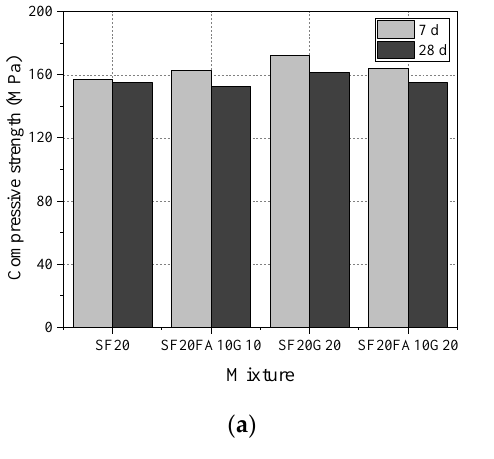
( b ) Figure 1. Compressive and flexural strengths of EUHPC under standard curing: ( a ) compressive strength; ( b ) flexural strength. 3.2.2. Mechanical Properties under Steam Curing The compressive and flexural strengths of EUHPC under steam curing are summa- rized in Table 4 and Figure 2. The compressive strength of specimens under steam curing fell within the range of 151.8 – 161.5 MPa at the age of 28 days and within the range of 155.1 – 172.5 MPa at the age of 7 days. There was no significant increase in 28 days com- pressive strength for all mixtures cured in steam conditions compared with the strength at 7 days; inversely, a slight reduction in the compressive strength was observed for some mixtures. For instance, the 28 days compressive strengths were decreased by 1.4%, 6.3%, 6.4%, 5.9%, and 5.7% in comparison with those at 7 days, while the 28 days compressive strength of S20F10G10 under steam curing had a slight increase of about 0.8% compared